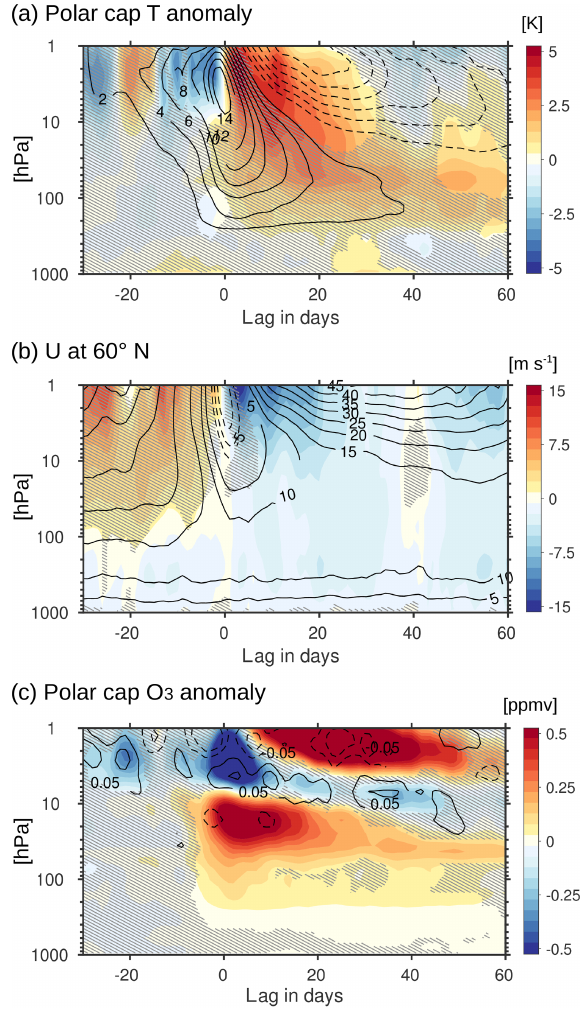
Figure 8. SSW composites for (a) the polar cap (60 to 90 ◦ N) temperature anomaly in K, (b) zonal mean zonal wind at 60 ◦ N in ms − 1 , and for (c) the polar cap ozone anomaly in ppm with lag in days with respect to the SSW central date (lag 0) and height. Contour lines show the composite for the Chem OFF run. Shading shows the difference between Chem ON and Chem OFF SSW composites. Contour intervals are (a) 2K, (b) 5ms − 1 , and (c) 0.05ppmv. Solid contours are used for positive values, and dashed contours are used for negative values. The zero contour is omitted. Statistically insignificant areas are hatched at the 90% level (two-sample t